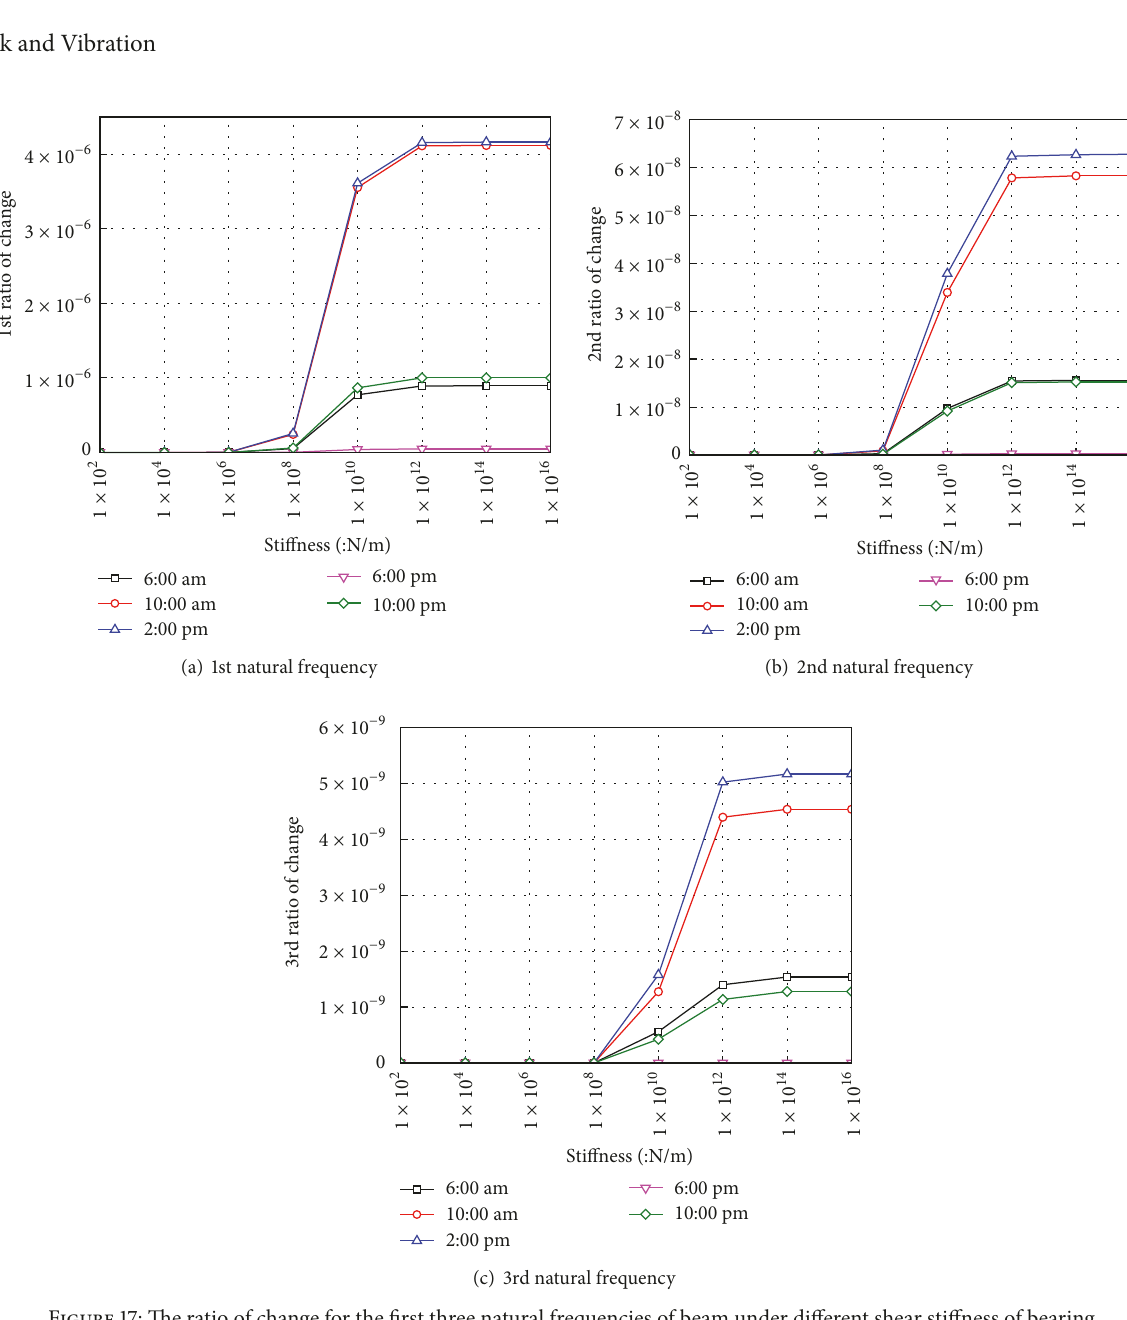
The fiber Bragg grating temperature